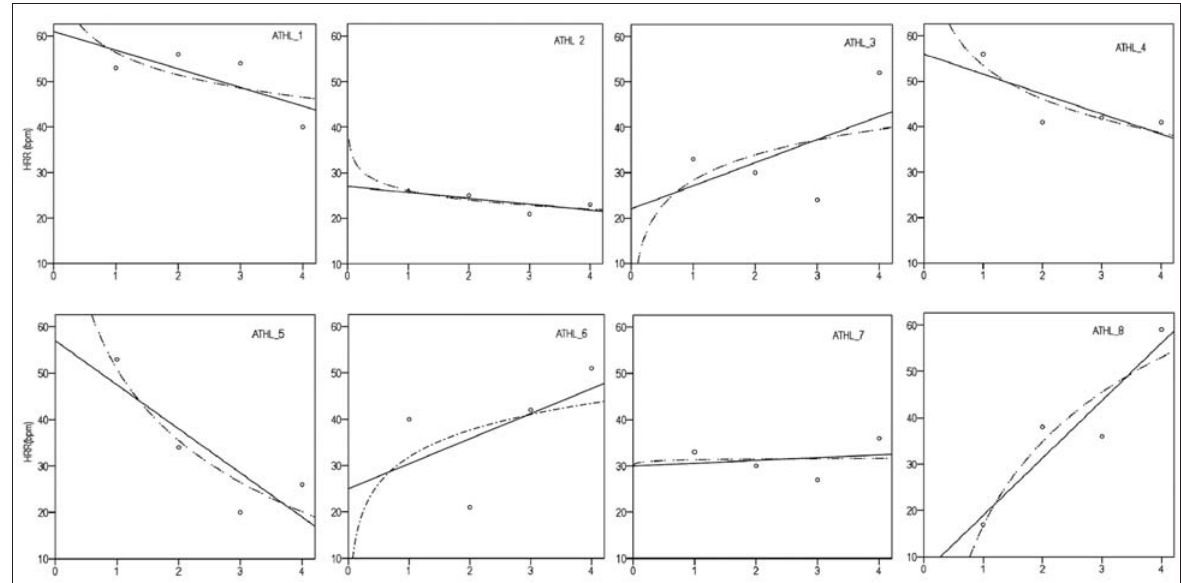
Figure. Individual trends in HRR of the investigated